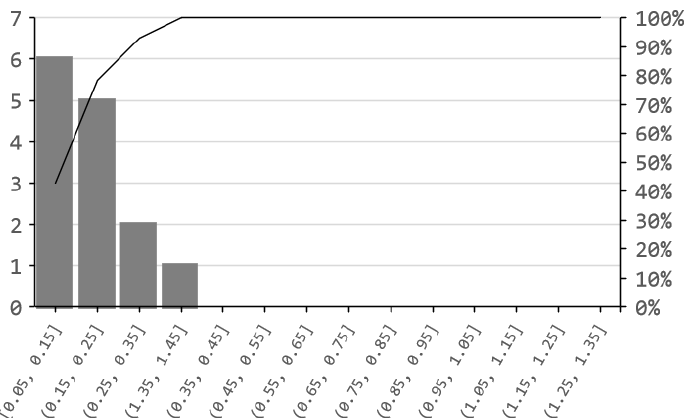
Figure 6. D 12 indicator frequency distribution diagram.